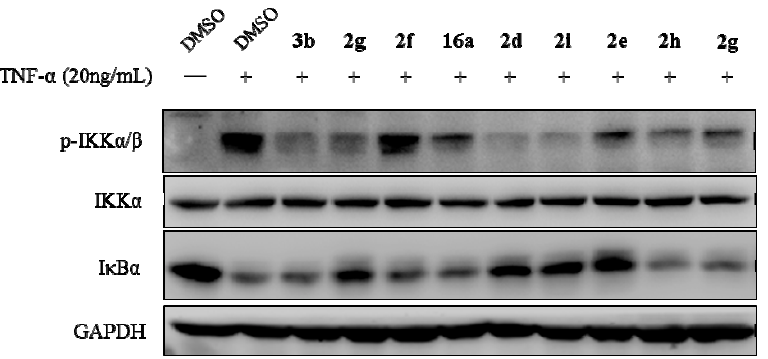
Figure 3. BBR analogues inhibited TNF - α -induced NF- κ B activation by impairing I κ B kinase (IKK) phosphorylation. Following pretreatment with BBR analogs 2d – j , 3b and 16a (10 µ M) for 2 h, 293T cells were treated with TNF- α (20 ng/mL) for 30 min. The phosphorylation of IKK α / β (Ser180/181) and